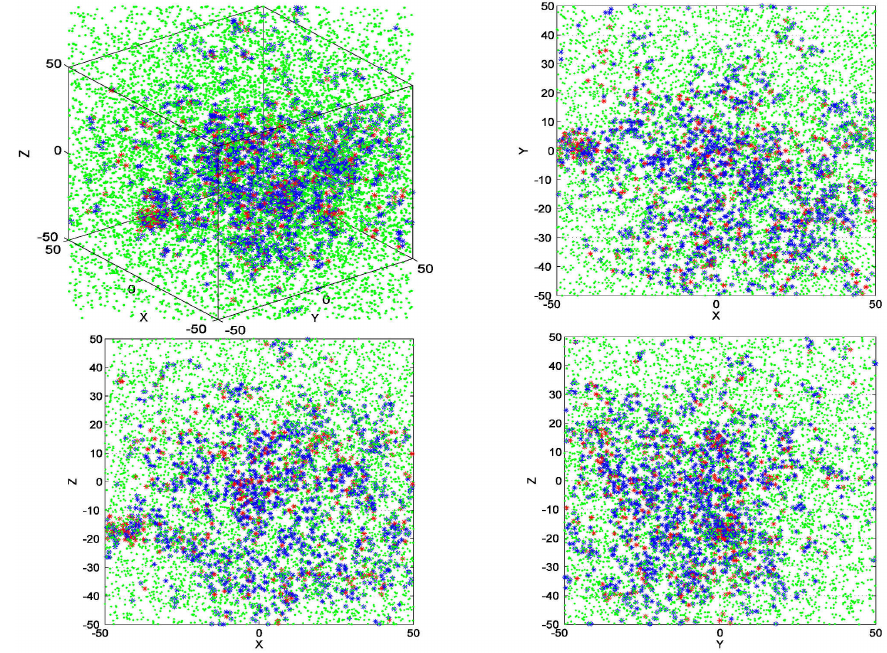
Fig. 10. Example of a spatial distribution of fractal complexes in the Galactic Carte- sian coordinate system. Here ( X; Y; Z ) are in parsecs. The red and blue asterisks are complexes of stars with [Fe/H] > 0 and [Fe/H] < 0, respectively. All complexes have fractal dimensions D that differ by more than two standard deviations from the corre- sponding dimension of a random distribution ( D > mean D + 2 (cid:27) RD ). The scale factor is equal to Mf = 5 pc. The green dots represent all stars of the